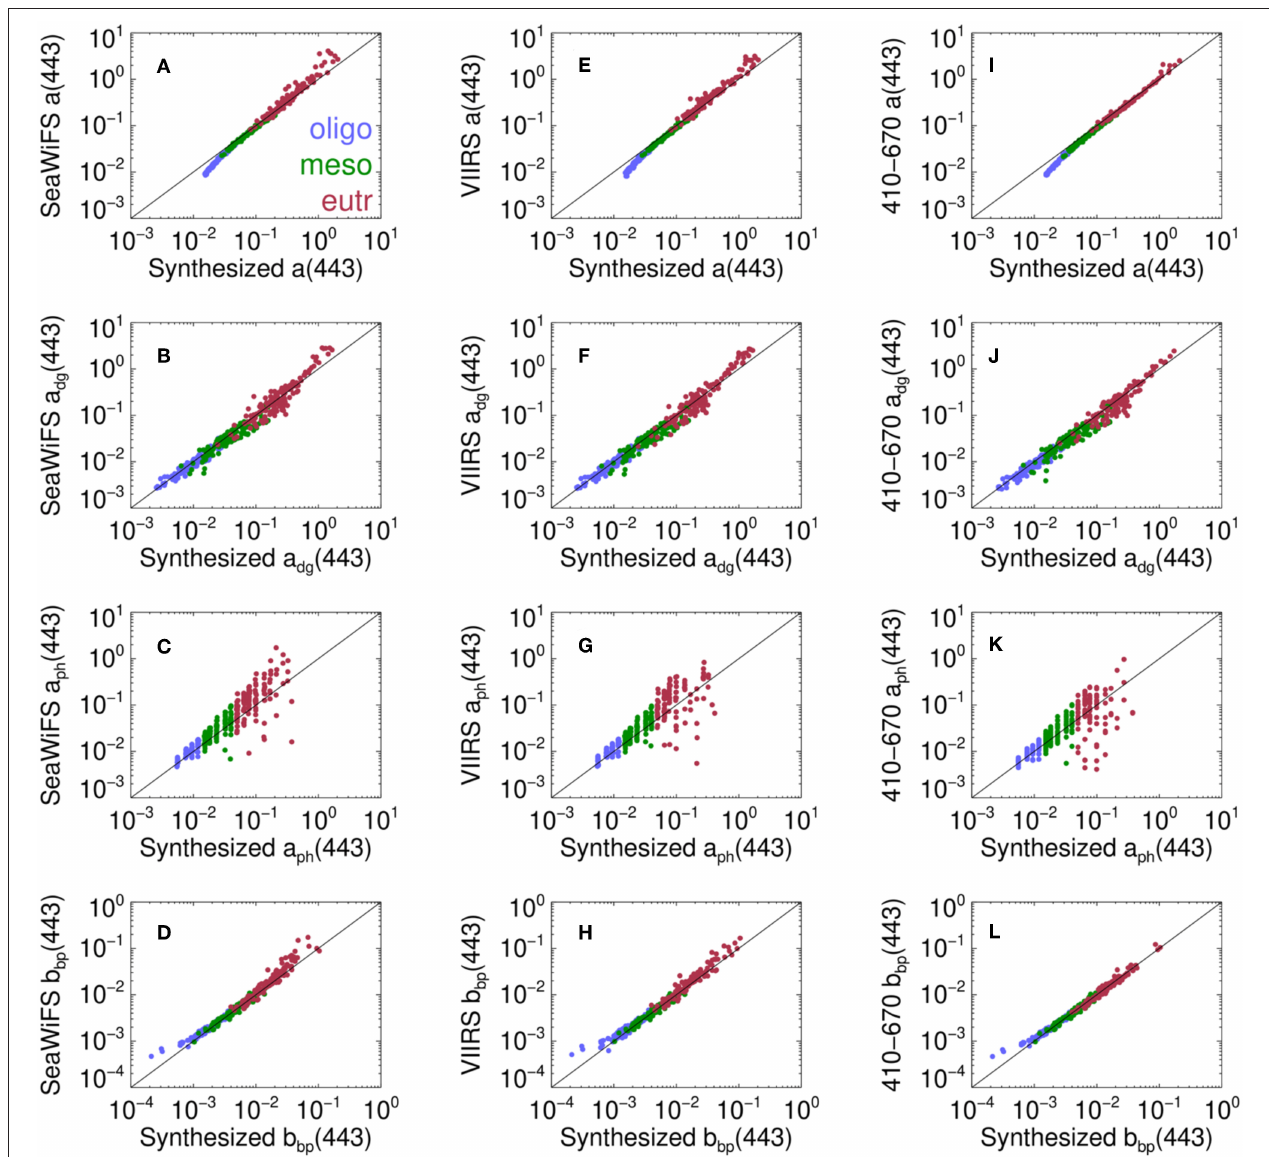
FIGURE 2 | Synthesized-vs.-satellite IOPs at 443nm for SeaWiFS (A–D) , VIIRS (E–H) , and 410–670nm (I–L) . IOPs include a (443) (A,E,I) , a dg (443) (B,F,J) , a ph (443) (C,G,K) , and b bp (443) (D,H,L) . The solid line represents a 1:1 relationship. The colors indicate chlorophyll-a ranges, with the oligotrophic range presented in red ( C a ≤ 0.1mg m − 3 ), the mesotrophic in green (0.1 < C a < 1mg m − 3 ), and the eutrophic in red ( C a ≥ 1 mg m − 3